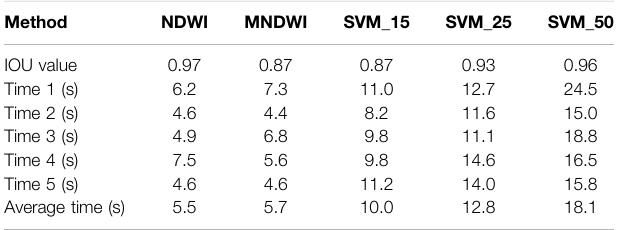
TABLE 2 | IoU value and running time of the Tuosu Lake water body extracted by different models. Method